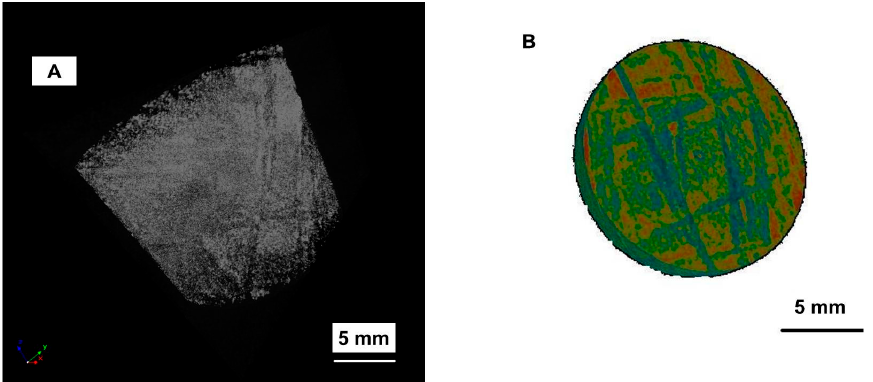
Figure 3. Volume rendered NCT image ( A ) of the Muonionalusta sample and ( B ) false color reconstructed axial section.